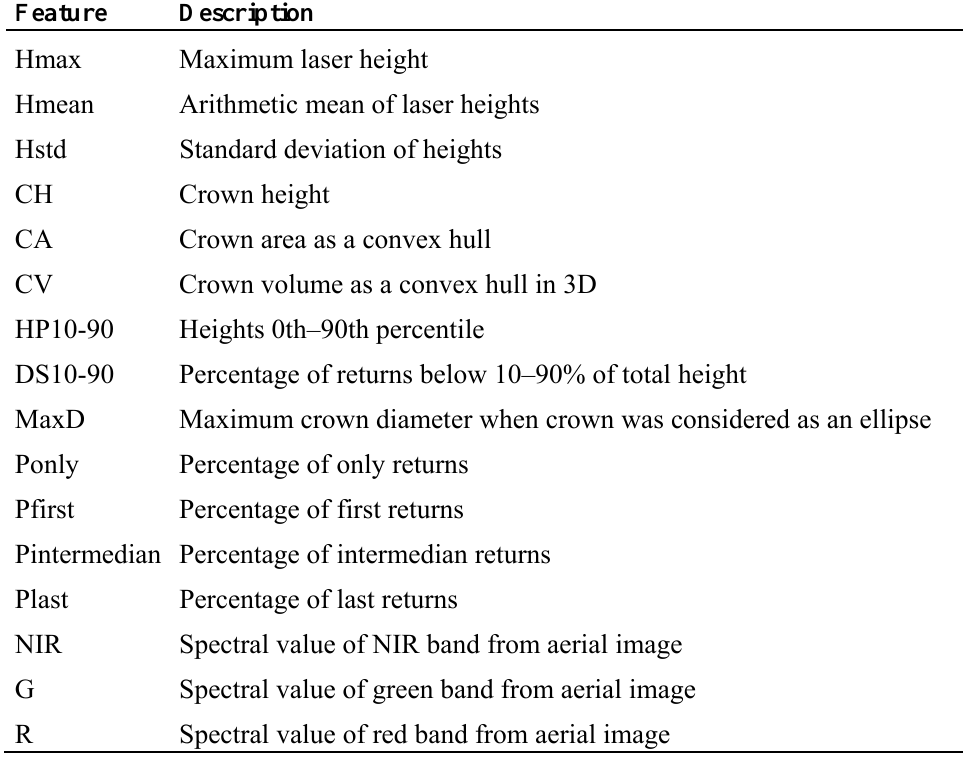
Table 2. Features extracted from ALS data and aerial images for individual